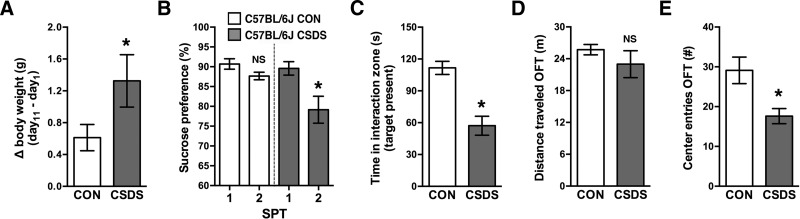
CSDS induces a depressive-like state in C57BL/6J mice. A, CSDS mice had greater weight gain compared with nondefeated control (CON) mice (days 1 – 11; t(1,14) = 2.28, *p = 0.039). B, CON mice did not show a significant decrease in sucrose preference during two-bottle SPT2 compared with SPT1 (t(1,7) = 1.96, p = 0.1). CSDS mice demonstrated lower sucrose preference during SPT2 compared with SPT1 (before CSDS; t(1,7) = 3.16, *p = 0.016). C, CSDS mice spent less time in the interaction zone with target present during the social interaction test on day 11 (t(1,14) = 5.04, *p = 0.00018). D, Locomotor activity did not differ significantly between experimental groups during OFT on day 12 (t(1,14) = 1.01, p = 0.33). E, CSDS mice enter OFT center zone less than CON mice (t(1,14) = 2.99, *p = 0.01). NS, Not significant. n = 8/group for all experiments.